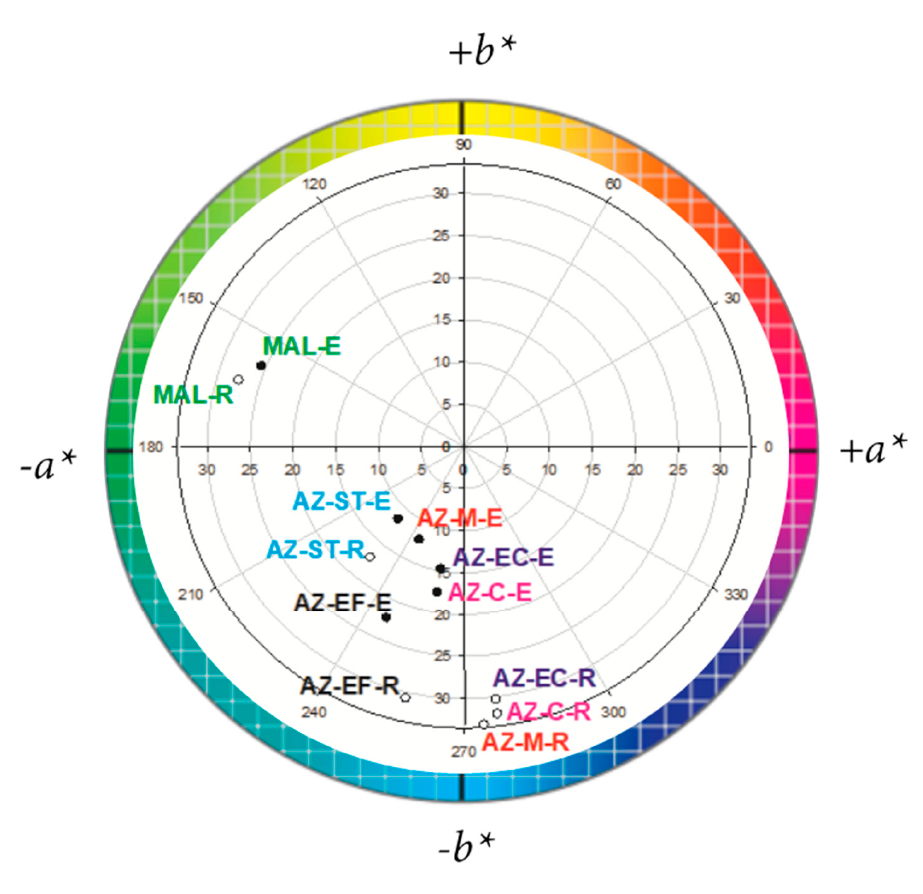
Figure 2. a*–b* polar plot of the fresh azurite (AZ) and malachite (MAL) egg yolk (E) and rabbit glue (R)-based paint mock-ups. EC = extra coarse grain size; C = coarse grain size; M = medium grain size; EF = extra fine grain size; ST = standard grain size.